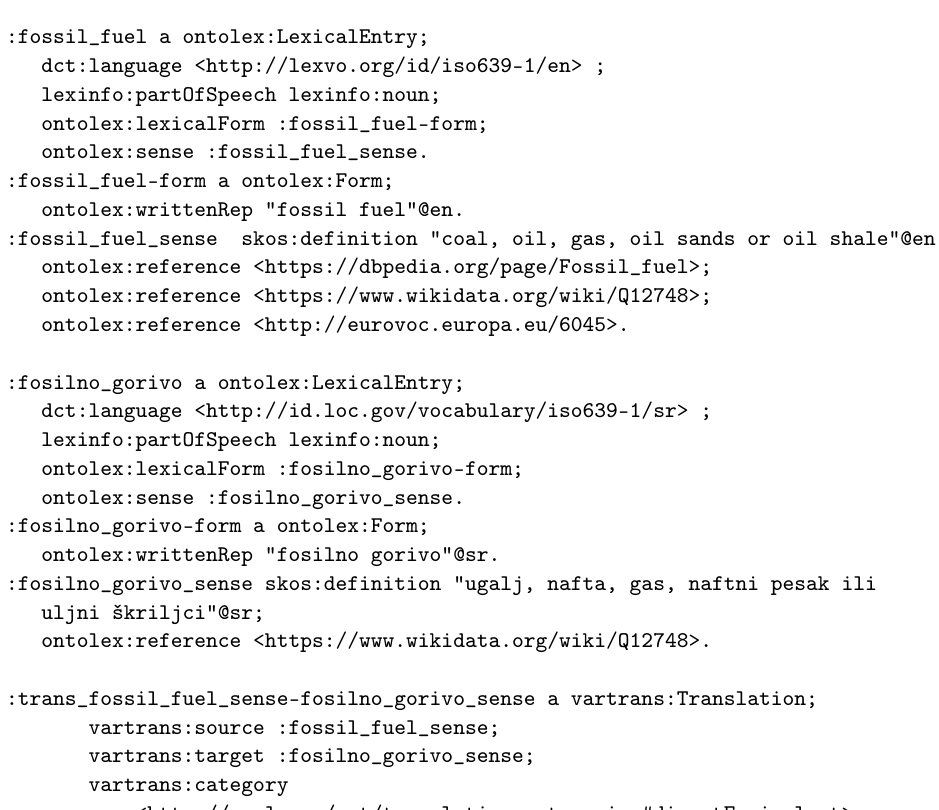
Figure 4. The graph for the translation of lexical entries: ‘fossil fuel’ - ‘fosilno gorivo’